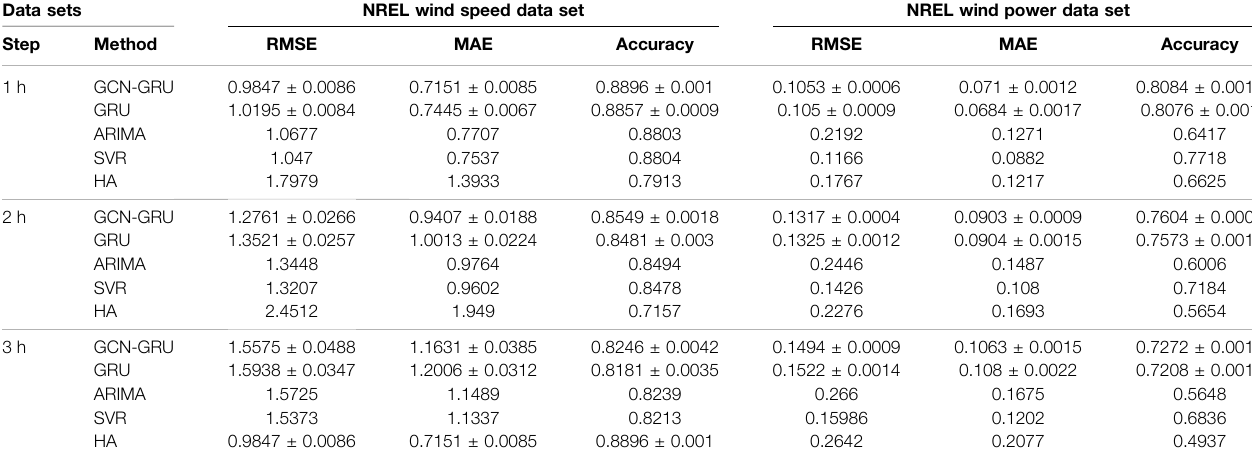
TABLE 2 | The results of NREL wind experiments. Data